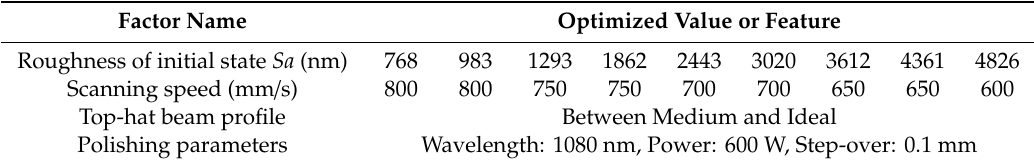
Table 2. Optimized parameters of CW laser polishing in each